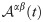
Time evolution of attraction between categories.The three panels show the values of the attraction coefficients Aαβ(t) respectively for α = 4 (“Goods”), α = 5 (“2nd hand”), and α = 7 (“Repair”), with respect to all the other categories, namely β = 1, …, 8. The radius R was set equal to 200 meters.